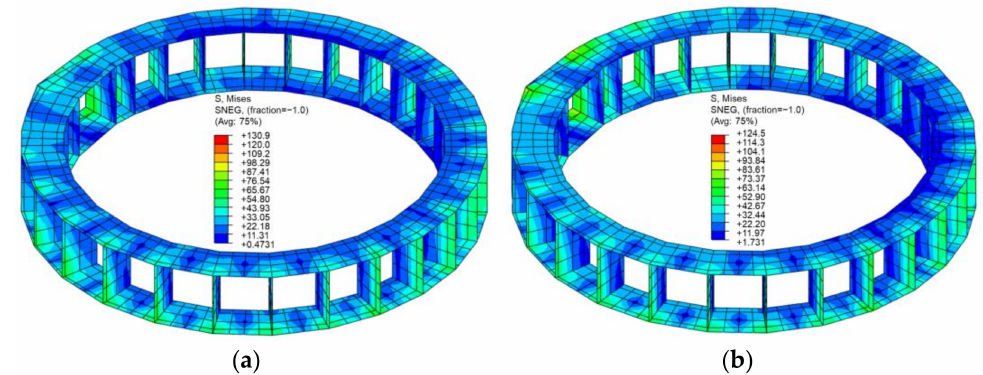
Figure 22. Mises stress of the stay ring (MPa): ( a ) non-circle case; ( b ) circle case. Overall, the SSC with non-circle sections requires higher standard for construction, and SSCs with both non-circle and circle sections are actually feasible with high-quality construction